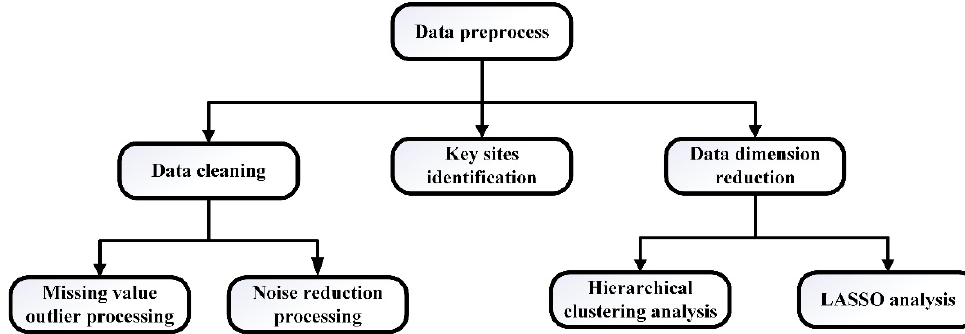
Figure 1. Preprocessing frame for factory data.